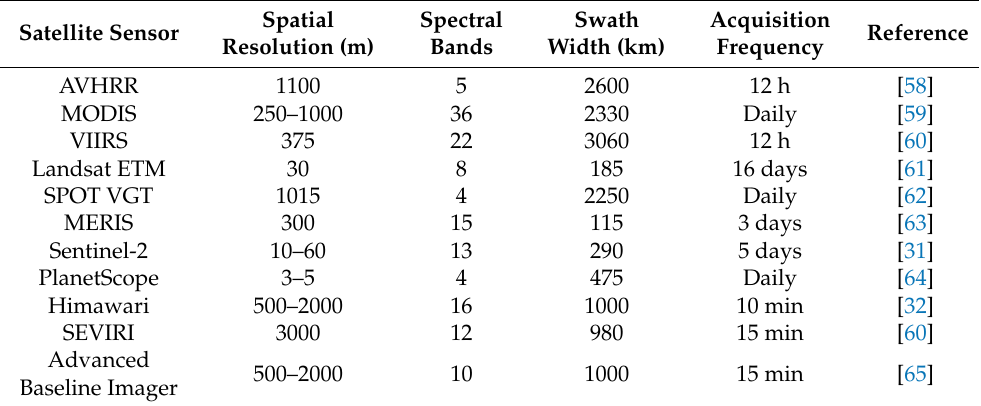
Table 1. Summary of widely used satellite sensors used in estimating LSP in rangeland ecosystems. Satellite